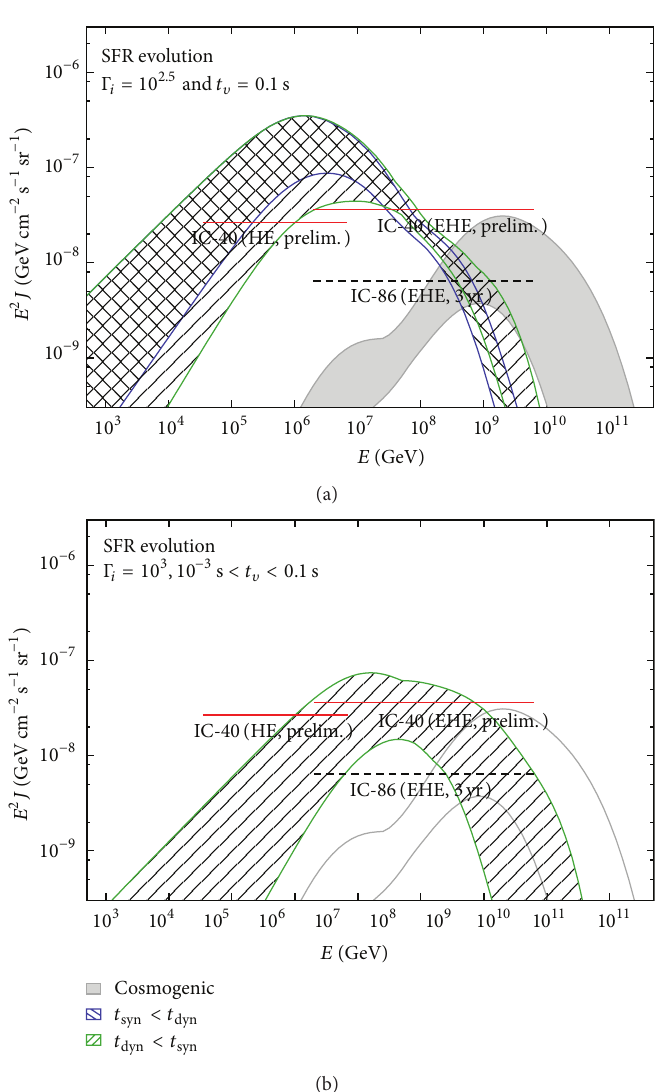
Figure 4: GRB neutrino spectra (the prompt spectrum emitted by the sources and neutrino spectrum generated in GZK interactions are shown separately), assuming the luminosity range 0.1 < (𝜖 𝐵 /𝜖 𝑒 )𝐿 𝛾,52 < 10 and star-forming redshift evolution of the sources. Here, 𝜖 𝑒,𝐵 are the fractional energies in the fireball carried by the electrons and the magnetic field; the two are equal in the case of equipartition. 𝐿 𝛾,52 is the photon energy in units of 10 52 erg. We show the prompt spectra separately for models where the fireball’s dynamical time scale 𝑡 (green right-hatched and blue cross-hatched, resp.). Here, the dynamical time scale smaller (larger) than the synchrotron loss time scale 𝑡 syn = 𝑡 𝑡 󸀠 = 𝑡 Γ . The IceCube limits [46] on the total neutrino flux from the analysis of high-energy and is just the variability scale 𝑡 𝑣 and 𝑣 dyn dyn ultra-high-energy muon neutrinos with the 40-string subarray assume 1:1:1 flavor composition after oscillation. We also show the sensitivity of the full IceCube detector (IC-86) to muon neutrinos after 3 years of observation. The gray solid area shows the range of GZK neutrinos expected at the 99%